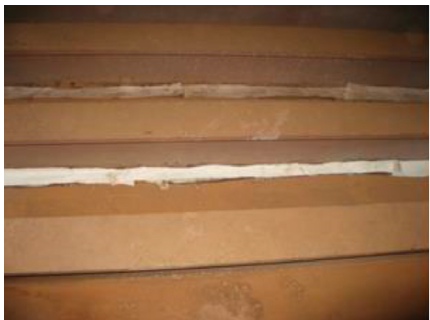
Figure 4: Distributed sensing fiber line on the bottom plate of the steel box